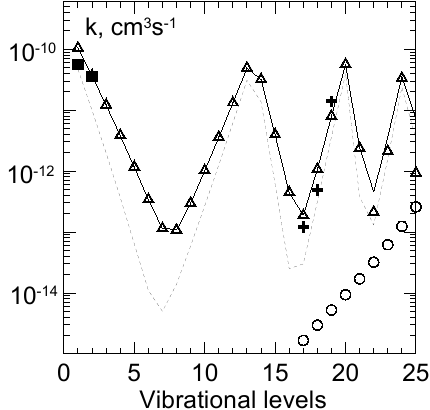
Fig. 10. The calculated total quenching rate coefficients of O 2 ( a 1 1 g , v )+O 2 (X 3 6 − g , v =0) at temperatures of 155 and 300K Figure 10. The calculated total quenching rate coefficients of O 2 (a 1 ∆ g ,v) + O 2 (X 3 Σ g– ,v=0) at (dotted and solid lines, respectively) are compared with experimen- temperatures of 155 and 300 K (dotted and solid lines, respectively) are compared with tal data by Hwang et al. (1998) (squares) and Amaral et al. (2002), experimental data by Hwang et al. (1998) (squares) and Amaral et al. (2002), Slanger and Slanger and Copeland (2003) (crosses). The calculated contribu- Copeland (2003) (crosses). The calculated contributions of processes (6a) and (6b) at room tions of processes (6a) and (6b) at room temperature – triangles and temperature – triangles and circles, respectively. circles, respectively.